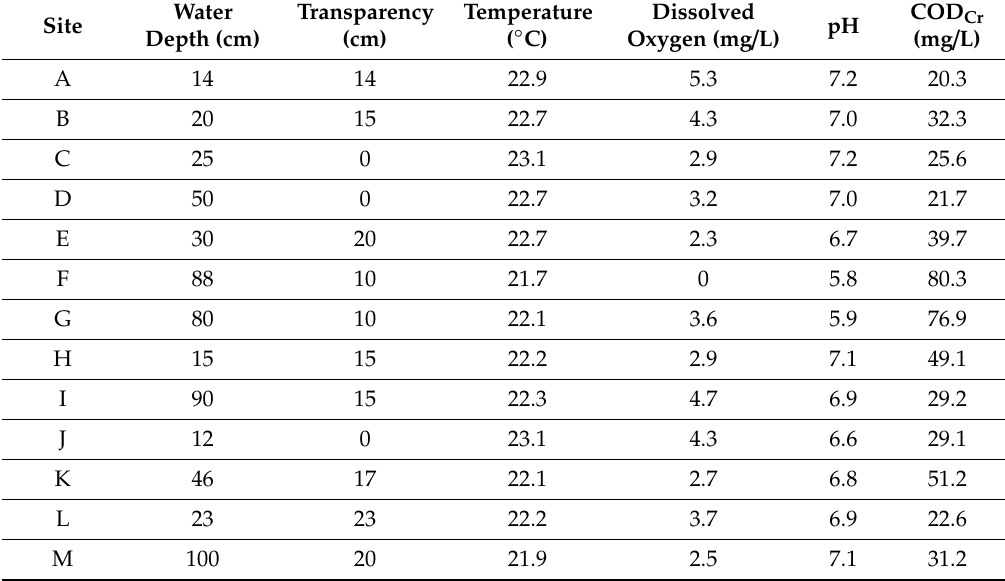
Table 1. Water quality of investigation